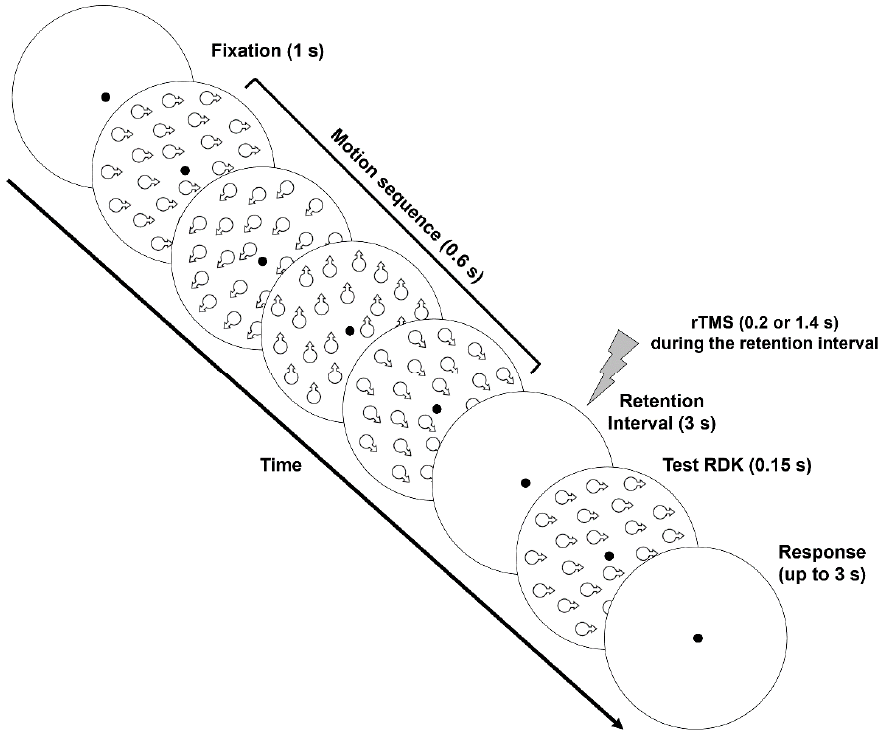
Figure 1. Schematic representation of stimuli and procedure used in the main rTMS VSTM experiment. An exemplary series of four RDKs moving in different directions is represented (sample motion sequence). After the 3 s retention interval, a test RDK is presented with the same direction as the first RDK in the sample motion sequence. rTMS (30 Hz) was delivered during the retention interval either 0.2 s or 1.4 s after the offset of the sample motion sequence. On each block, rTMS trials were randomly interleaved with No-TMS trials. Participants had 3 s to report whether the test RDK was presented or not in the sample motion sequence (Yes/No task). For experiment 1, the temporal characteristics of the TMS stimulation were mainly based on the studies of [10,59]. In each session, rTMS (3 pulses during a 100 ms interval; 30 Hz) was delivered either 0.2 s (early rTMS) or 1.4 s (late rTMS) after the offset of the sample motion sequence and during the 3 s retention interval. This procedure was designed to induce a stimulation-related interference either during the encoding phase (early TMS) or on the retention phase (late rTMS) of the memory items, respectively. A rapid sequence of pulses at 30 Hz has been shown to improve the efficacy and reliability of the interference effects of TMS compared to lower stimulation frequencies [60]. rTMS trials were interleaved by trials with no stimulation (i.e., No-TMS trials). Each combination of target serial position in the sample (i.e., first, second, third, or fourth serial position), test RDK present or absent in the sample motion sequence, and TMS interval (i.e., No-TMS, early TMS, and late TMS) was presented six times. Therefore, each participant completed 144 trials (i.e., 4 target serial positions × 2 test RDKs [present/absent] × 3 TMS intervals × 6 repetitions) split into 8 blocks of 18 trials each. This was done to allow frequent breaks between blocks to avoid the cumulative effects of rTMS and limit fatigue. Different conditions were randomly presented within each block. Within each session, the stimulation site was kept the same. Before the main VSTM experiment participants were familiarized with the experimental procedure and completed a practice block of 24 trials (i.e., 4 target serial positions × 2 test RDK [present/absent] × 3 repetitions).